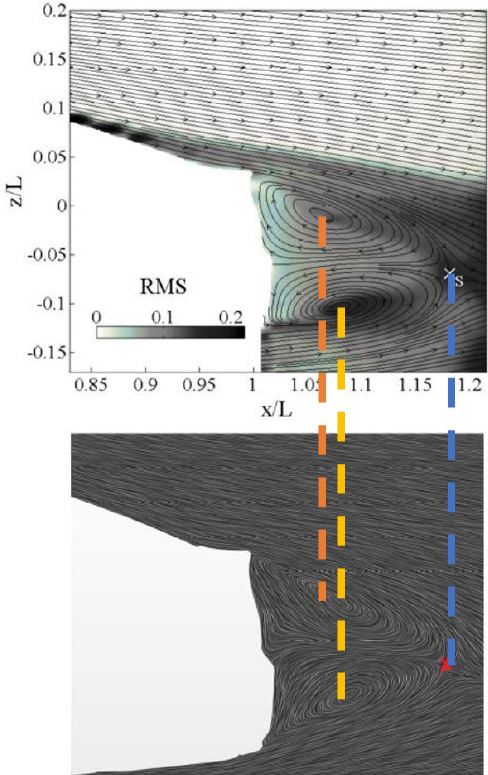
Figure 13. Wake Flow of Isolated DrivAer Fastback Simulation versus experimental [47] with key circulation zones compared using dashed lines.